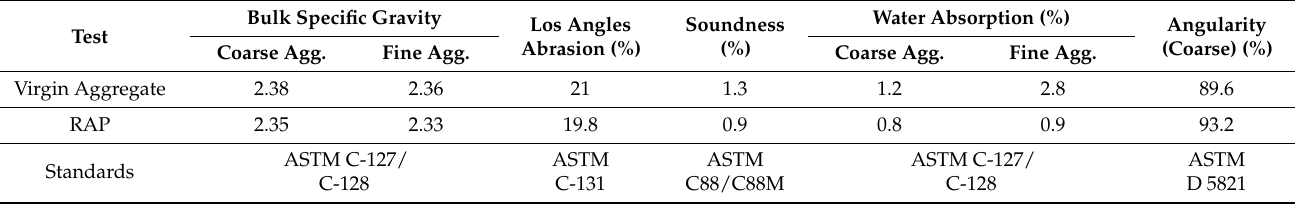
Table 2. The physical properties of the virgin aggregate and